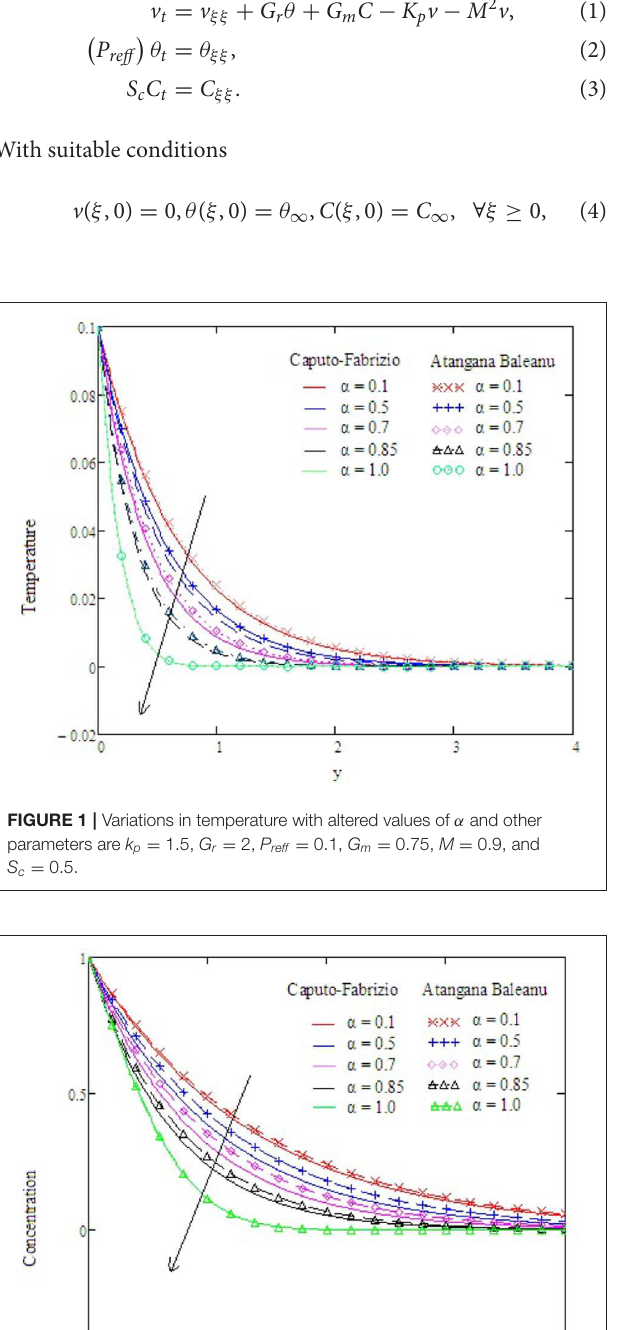
FIGURE 2 | Variations in concentration with altered values of α and other parameters are k p